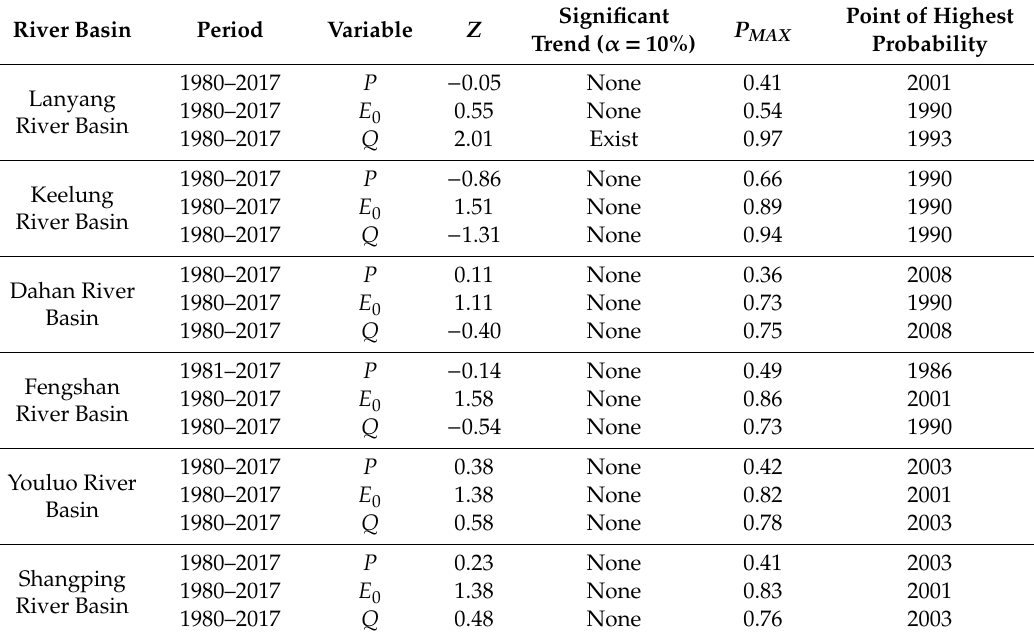
Table 3. Trend analysis and break point